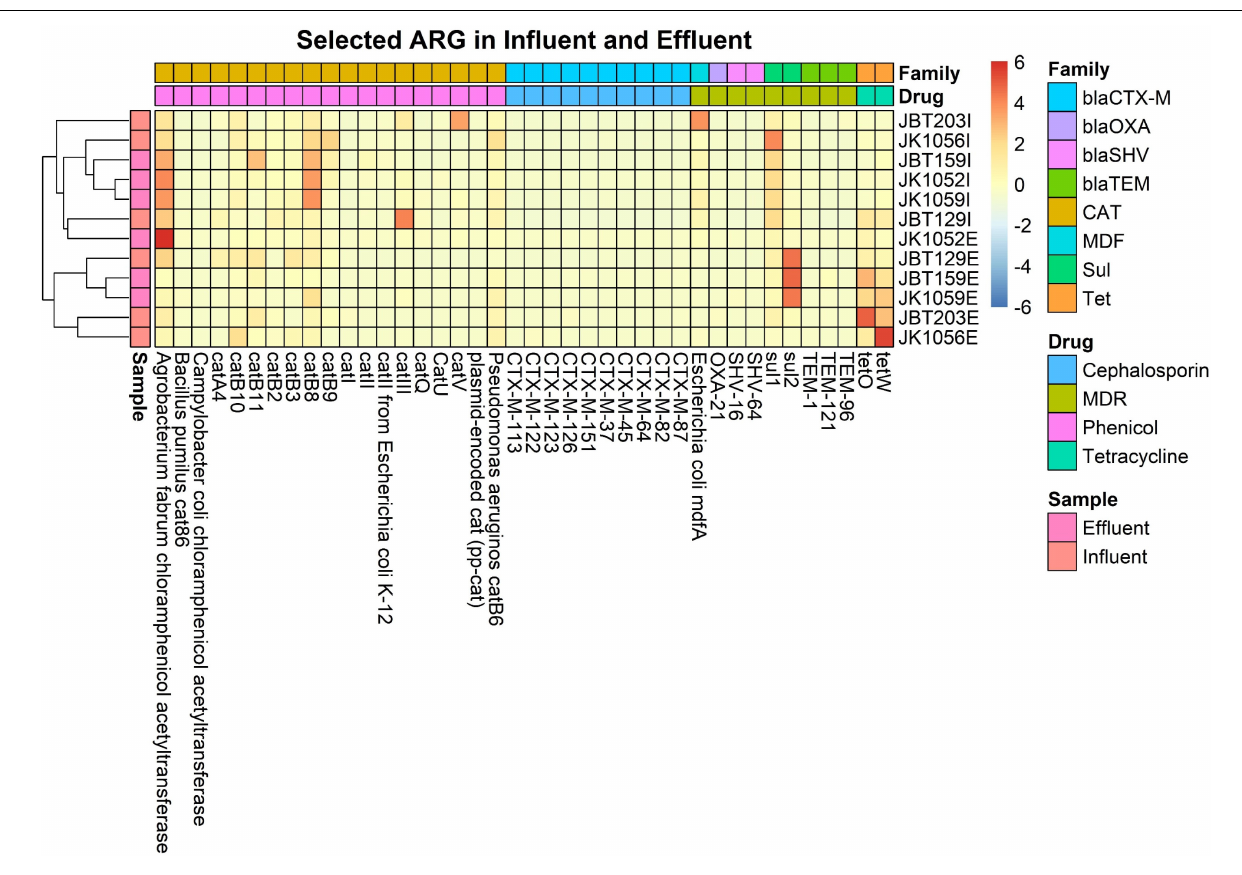
possible differences in the strength of interaction between the nodes (species and/or ARG) in respective sources. Both networks were reported with a modularity index > 0.4: 0.683 for the influent and 0.691 for the effluent, respectively. The modularity index values indicate the networks having a concrete modular network structure and not being random, further interpreted